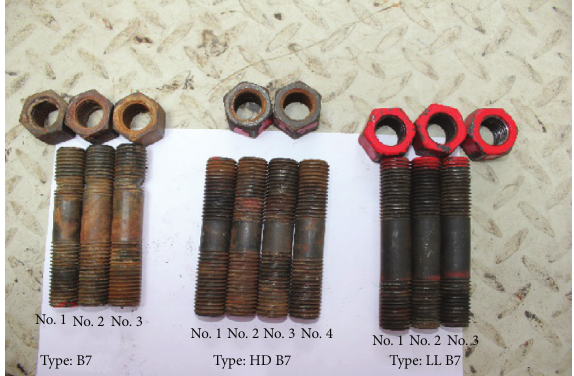
Figure 3: Bolts at flange